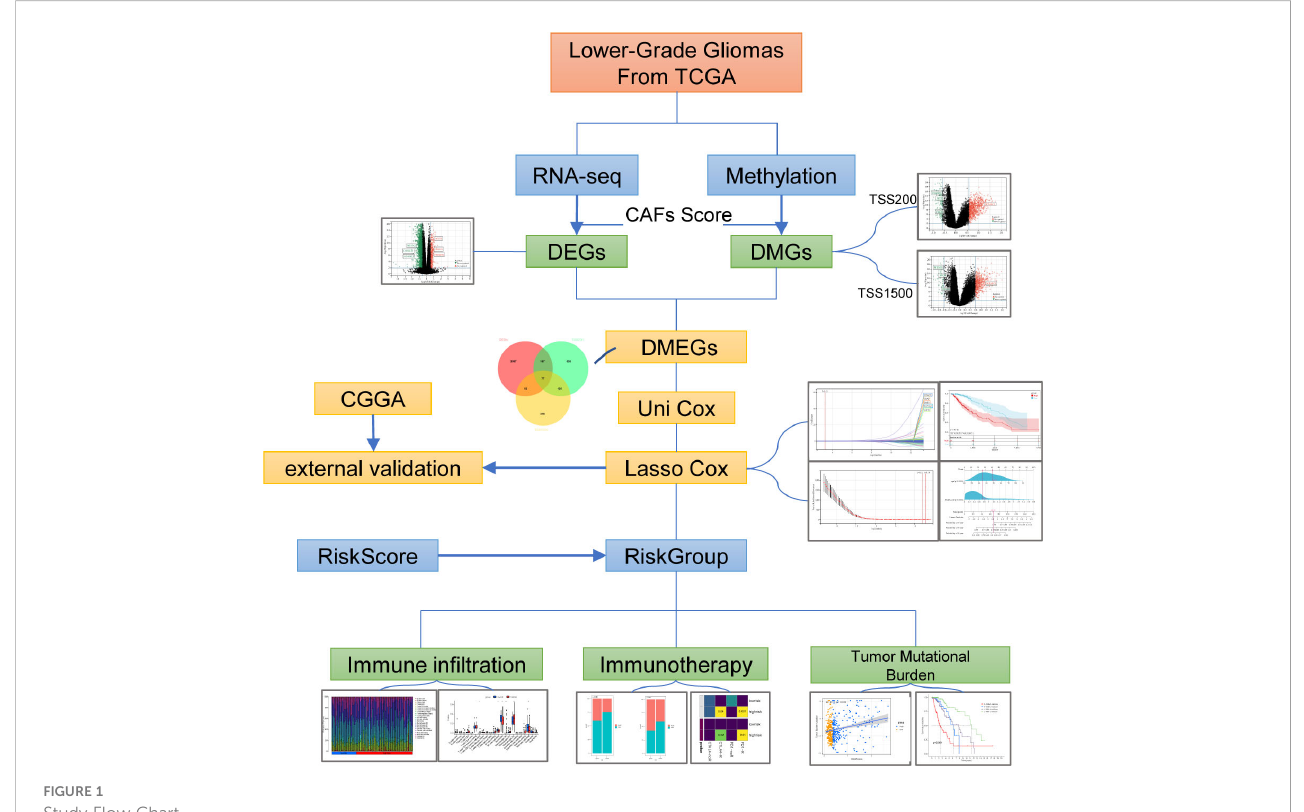
FIGURE 1 Study Flow